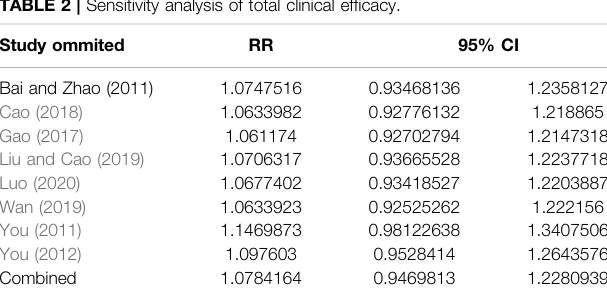
TABLE 2 | Sensitivity analysis of total clinical ef fi